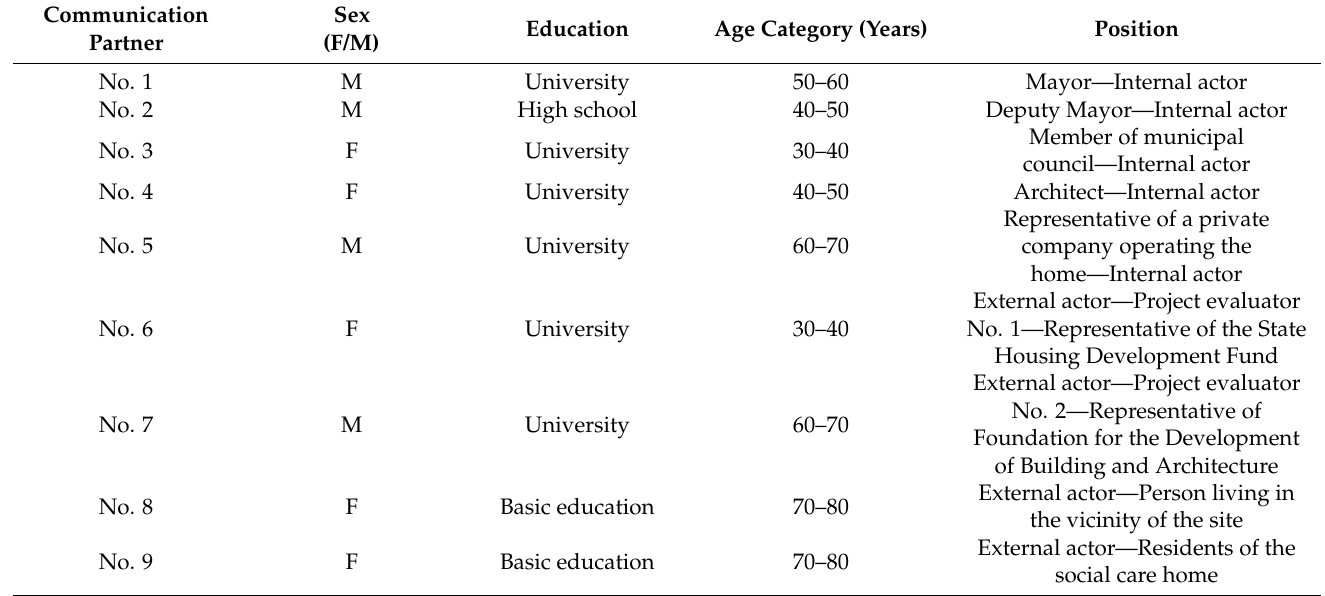
Table 2. Basic characteristics of interviewed communication